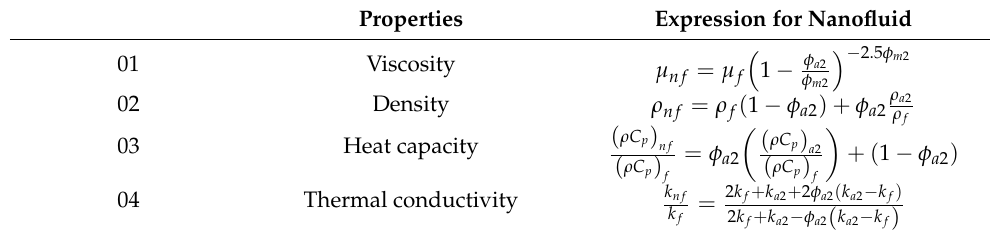
Table 1. Thermophysical properties of nanomaterials.